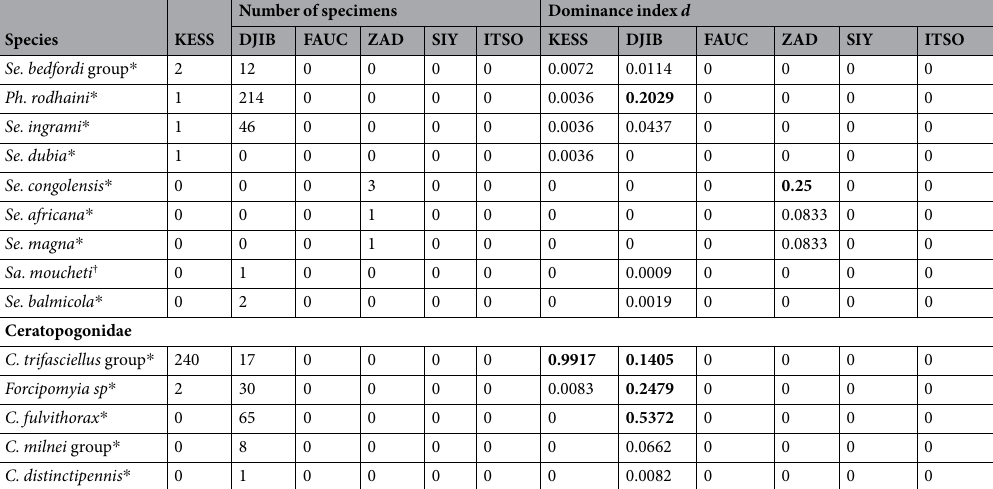
Table 2. Composition of mosquito, sand fly and biting midge species assemblages in the Gabonese caves under study. KESS : Kessipoughou, DJIB : Djibilong, FAUC : Faucon, ZAD : Zadie, SIY : Siyou, ITSO :